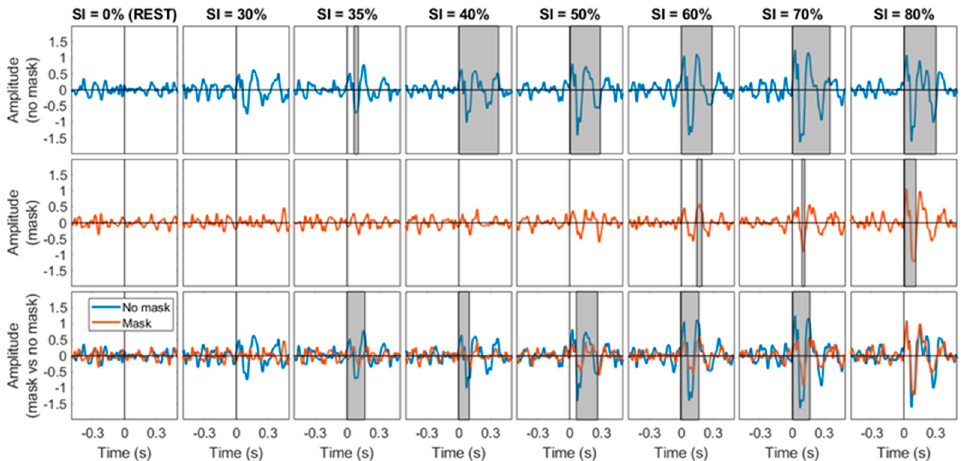
Figure 6. AEPs for the case of no mask (first row), use of auditory mask (middle row) and both (bottom row) for the different stimulation intensities (columns). The gray shaded patch corresponds to the time period of statistically significant difference between the AEPs for the comparison of stimulation vs. rest condition (first and second row), and stimulation with vs. without mask (third row).